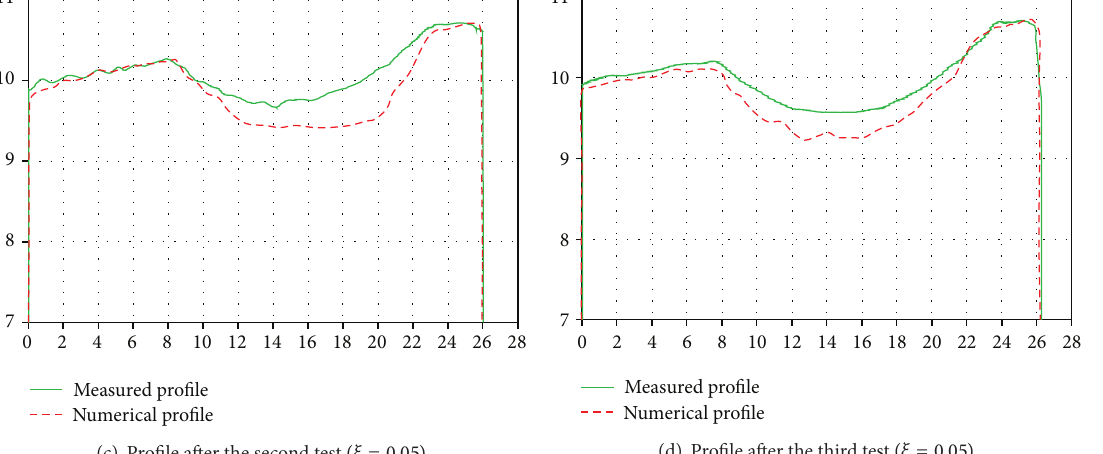
(b) Profile after the first test (𝜉 = 0.25)